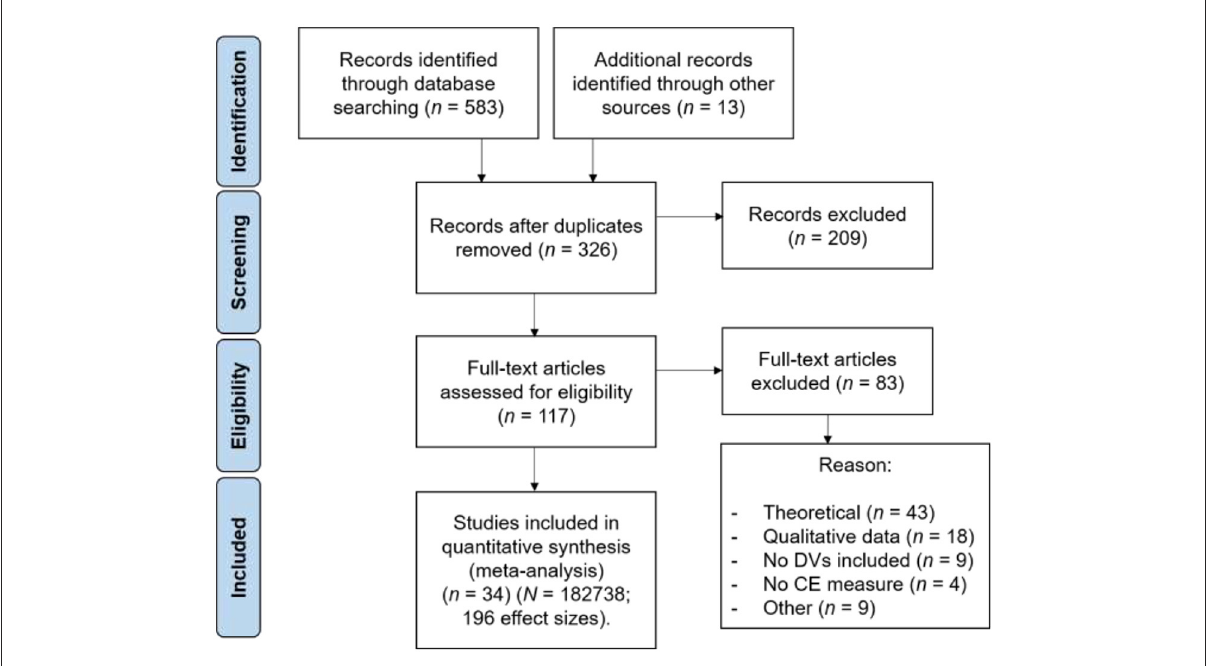
FIGURE1 Flow chart of the studies identified and selected, following the PRISMA guidelines.